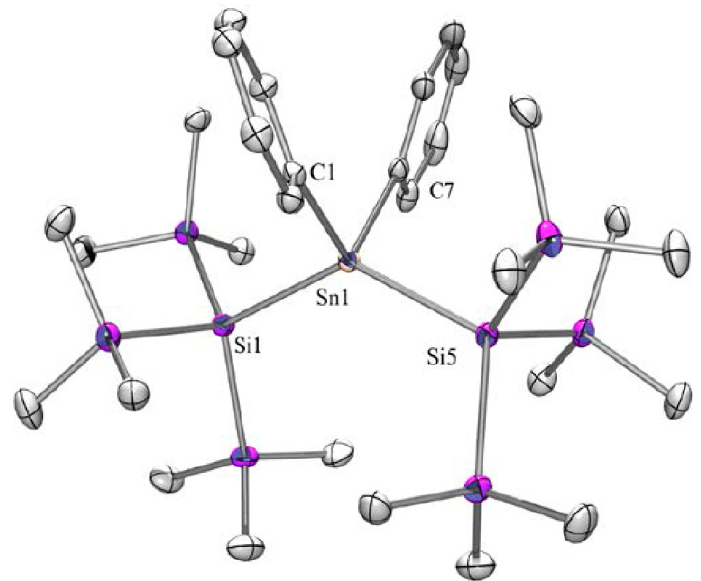
Figure 1. Molecular structure of 2 (thermal ellipsoid plot drawn at the 30% probability level). All hydrogen atoms are not shown for clarity (bond lengths in Å, angles in °). Sn(1)–C(7) 2.1603(19), Sn(1)–